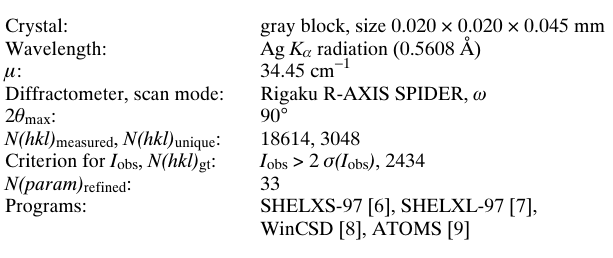
Table 3. Data collection and